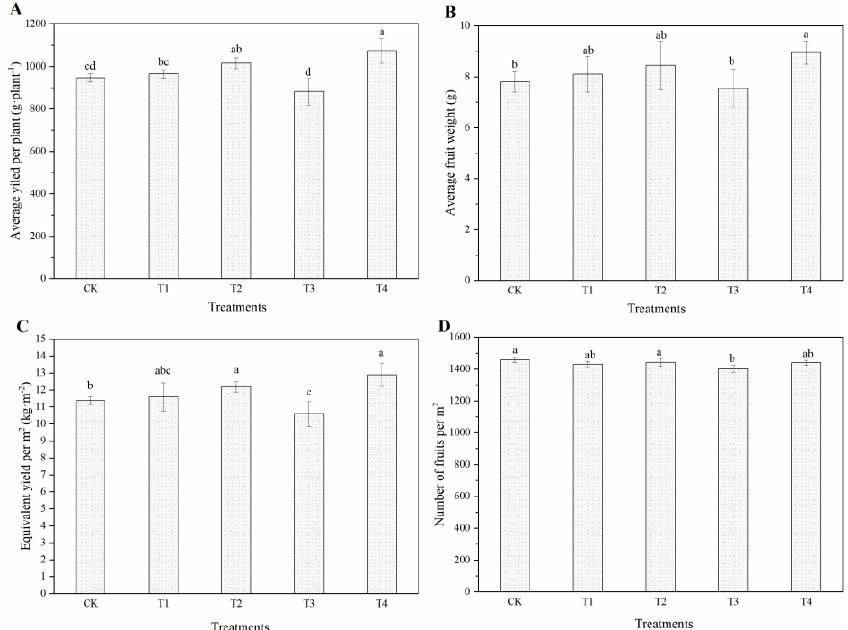
Figure 2. The yield of cherry tomato fruits supplied with different dynamic concentrations of nutrient solution. The average yield per plant ( A ), average fruit weight ( B ), equivalent yield per m 2 ( C ) and number of fruits per m 2 of cherry tomato fruits ( D ). The error bars represent the SD. Lowercase letters within the graph are used to compare individual mean values of the treatments, and different letters indicate significant differences ( p ≤ 0.05).